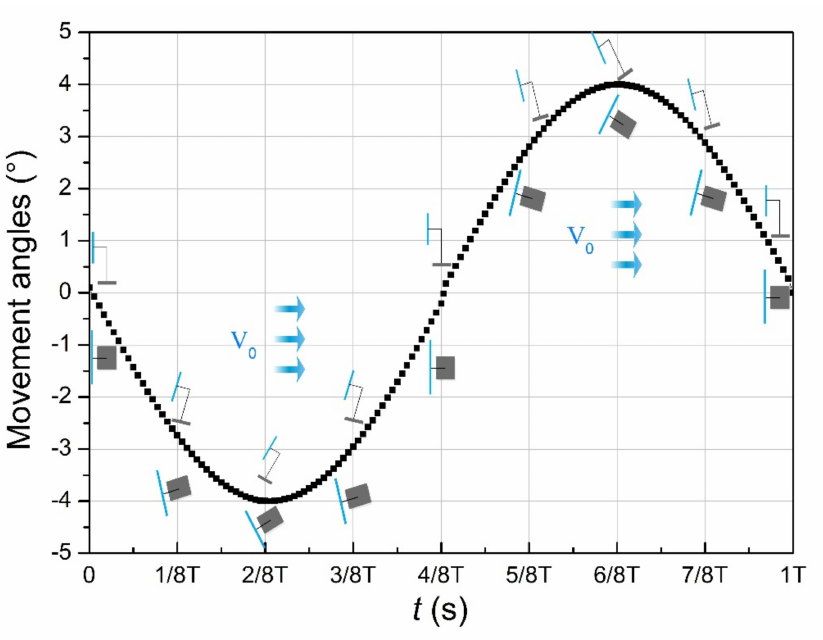
Figure 5. The variation of pitch and yaw angle at f = 0.1 Hz.